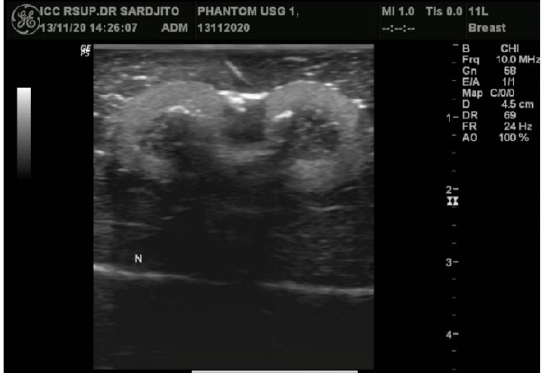
Fig.3: Ultrasound images of two artificial solid tumors made of olive and carrot pieces to represent oval inhomogeneous lesions. Olive flesh appeared as a mildly hyperechoic area at the edge of the lesion, while carrot pieces appeared as a hypoechoic area in the middle portion with a posterior shadow and several small linear hyperechoic areas.